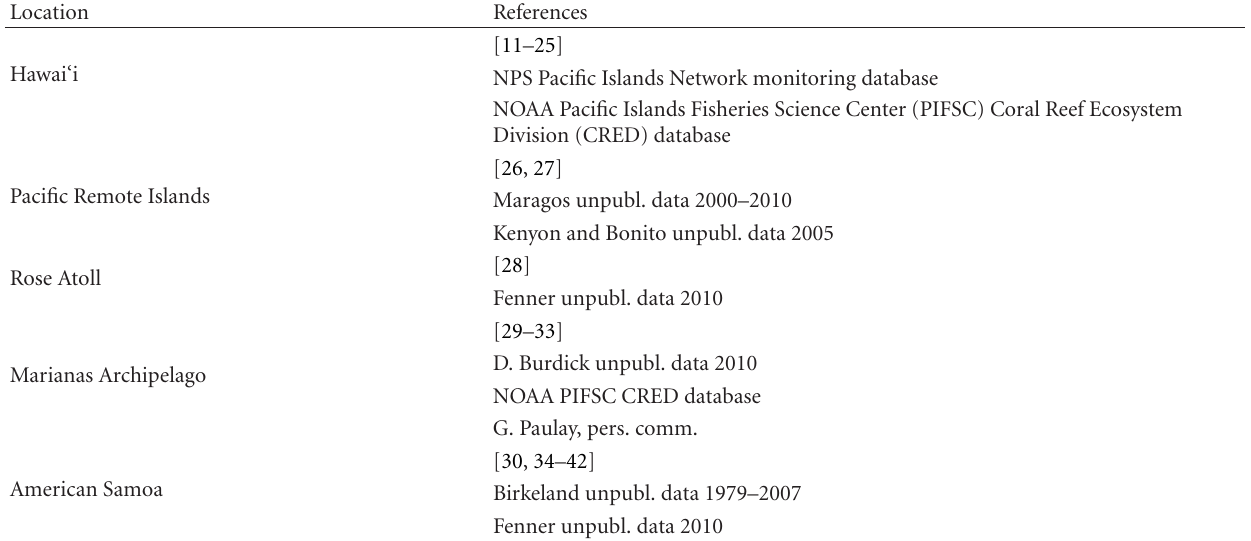
Table 2: Data sources used to substantiate the occurrence of 75IUCN Red List coral species in the US Pacific and in federally protected